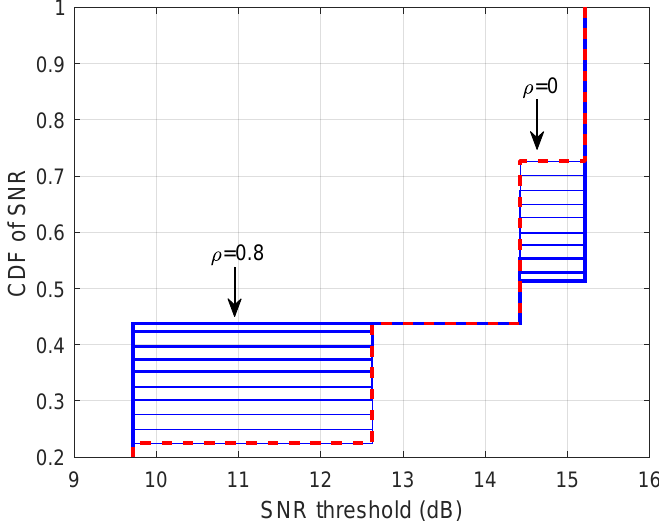
Figure 6. The CDF of the Signal to Noise Ratio (SNR) F SINR ( β ) using diversity combining for fixed location of X 1 and X 2 for different values of ρ . The dashed red line shows the CDF when ρ = 0, and the solid blue lines correspond to positive values of ρ in increments of